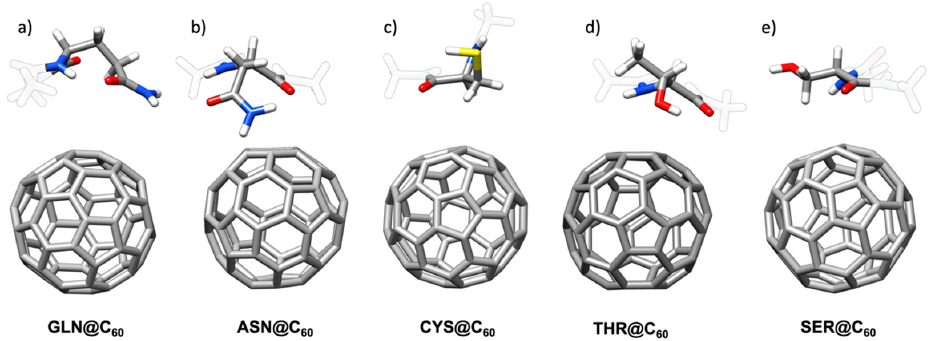
Figure 5. Snapshots from the MD of the interactions of polar amino acids ( a ) Gln, ( b ) Asn, ( c ) Cys, ( d ) Thr and ( e ) Ser with C 60 . For each amino acid, the most interactive configuration is shown. In this case, the hydrophobic part of the residues interacted with the fullerene sur- face, while the hydrophilic part continued to interact with water. The affinity of the resi- dues is directly proportional to the vdW interactions that the hydrophobic chain estab- lished with the C 60 cage. For example, Gln ( 𝐸 (cid:3029)(cid:3036)(cid:3041)(cid:3031)(cid:3036)(cid:3041)(cid:3034) (cid:3404) − 3.1 kcal mol − 1 ) interacted more strongly than Asn ( 𝐸 (cid:3029)(cid:3036)(cid:3041)(cid:3031)(cid:3036)(cid:3041)(cid:3034) (cid:3404) − 2.6 kcal mol − 1 ) due to a longer aliphatic chain, and Thr ( 𝐸 (cid:3029)(cid:3036)(cid:3041)(cid:3031)(cid:3036)(cid:3041)(cid:3034) (cid:3404) − 1.5 kcal mol − 1 ) interacted more strongly than Ser ( 𝐸 (cid:3029)(cid:3036)(cid:3041)(cid:3031)(cid:3036)(cid:3041)(cid:3034) (cid:3404) − 1.1 kcal mol − 1 )